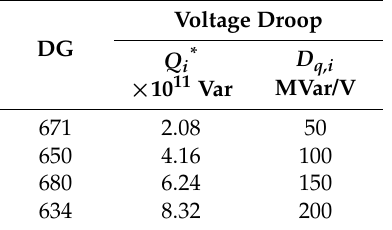
Table 3. Conventional Droop Control Coefficients.